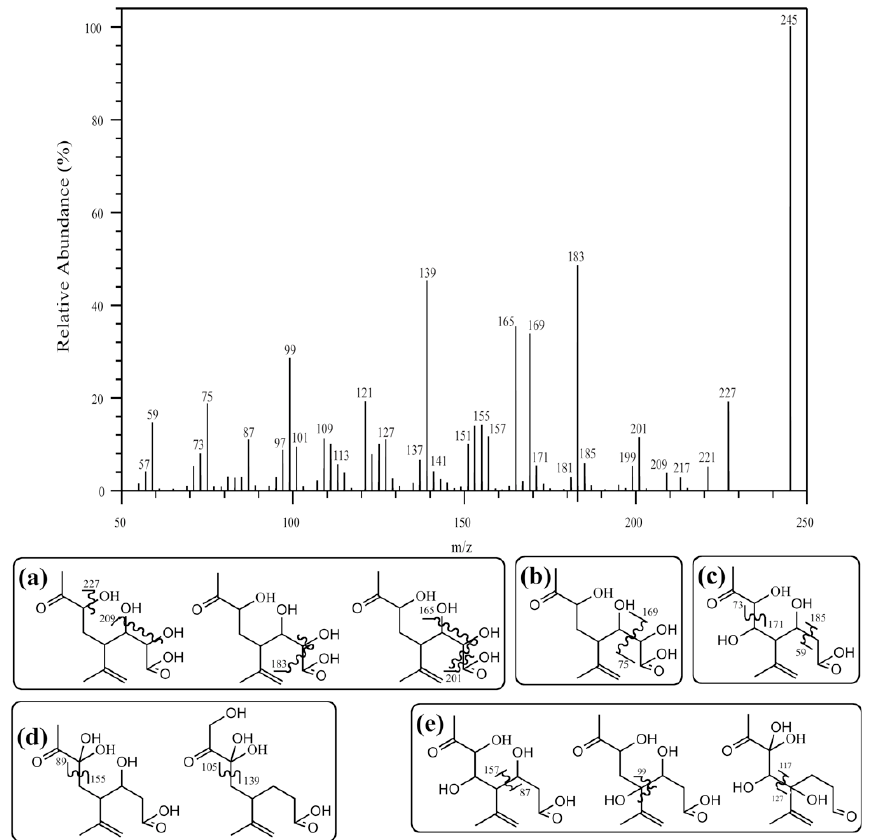
Fig. 7. Product ion mass spectrum of the fragmentation of m/z 245 ± 2. Infrared multiphoton dissociation technique (IRMPD) was used for the fragmentation of peaks using FT ICR-MS. Proposed structural isomers and their fragmentation processes are shown in the lower panel (a–e)